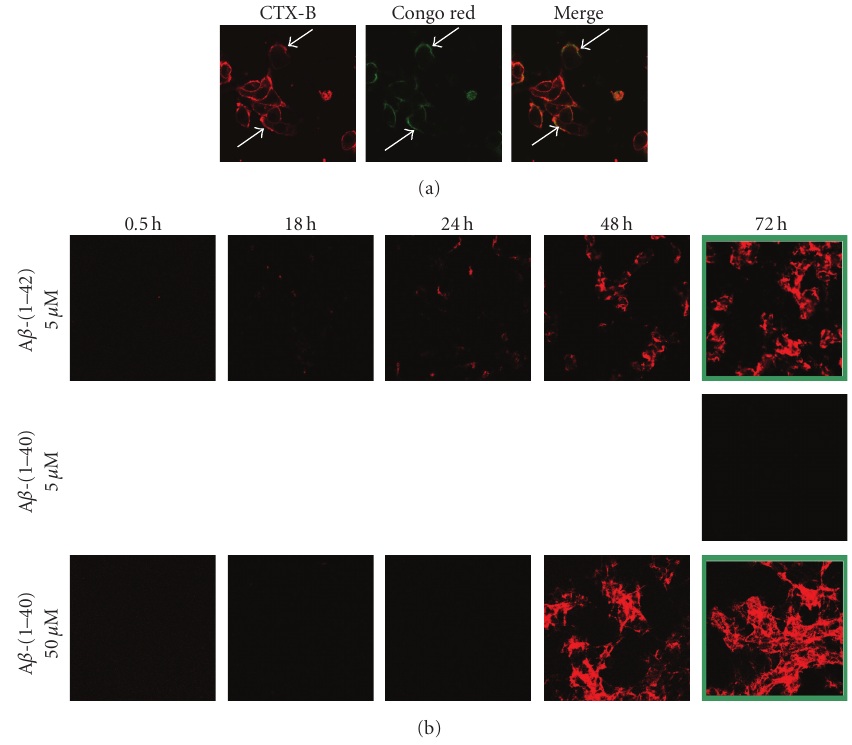
Figure 2: A β aggregation on living neuronal cells. (a) A β -(1–42) (10 μ M) was incubated with PC12 cells for 24h at 37 ◦ C. The distribution of GM1 was detected by using the cholera toxin B subunit conjugated with Alexa Fluor 647 dye (CTX-B, left). Amyloids were visualized by the amyloid-specific dye Congo red (middle). The merging of the two images shows that amyloids were formed in the vicinity of GM1-rich domains of cell membranes (right). Data taken from [10]. (B) Ganglioside-expressing SH-SY5Y cells were incubated with 5 μ M A β -(1–42) (top), 5 μ M A β -(1–40) (middle), or 50 μ M A β -(1–40) (bottom) for 0.5, 18, 24, 48, or 72 h, and the formation of amyloids was detected with Congo red. The conditions under which cell death was observed are framed in green. Data taken from